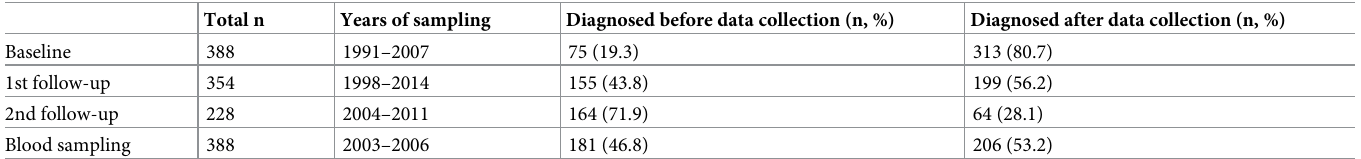
Table 1. Number of CAMO study participants with pre- or post-diagnostic information from baseline and follow-up questionnaires. Total n Years of sampling Diagnosed before data collection (n, %) Diagnosed after data collection (n,